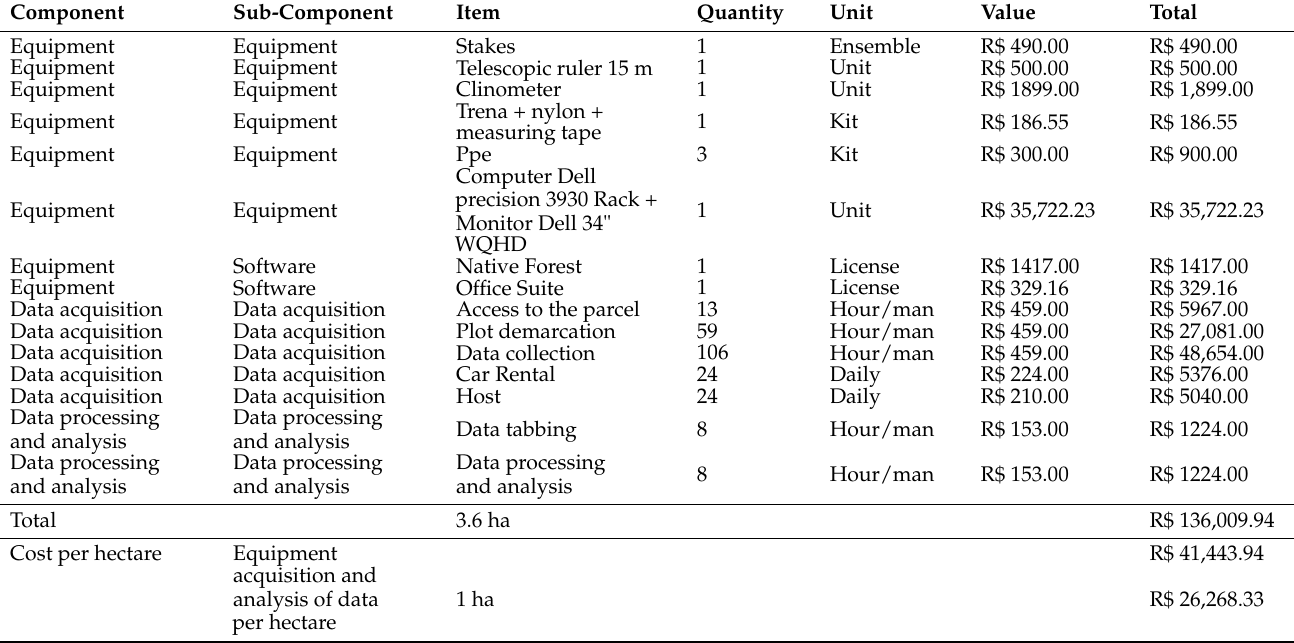
Table A1. Traditional forest inventory cost